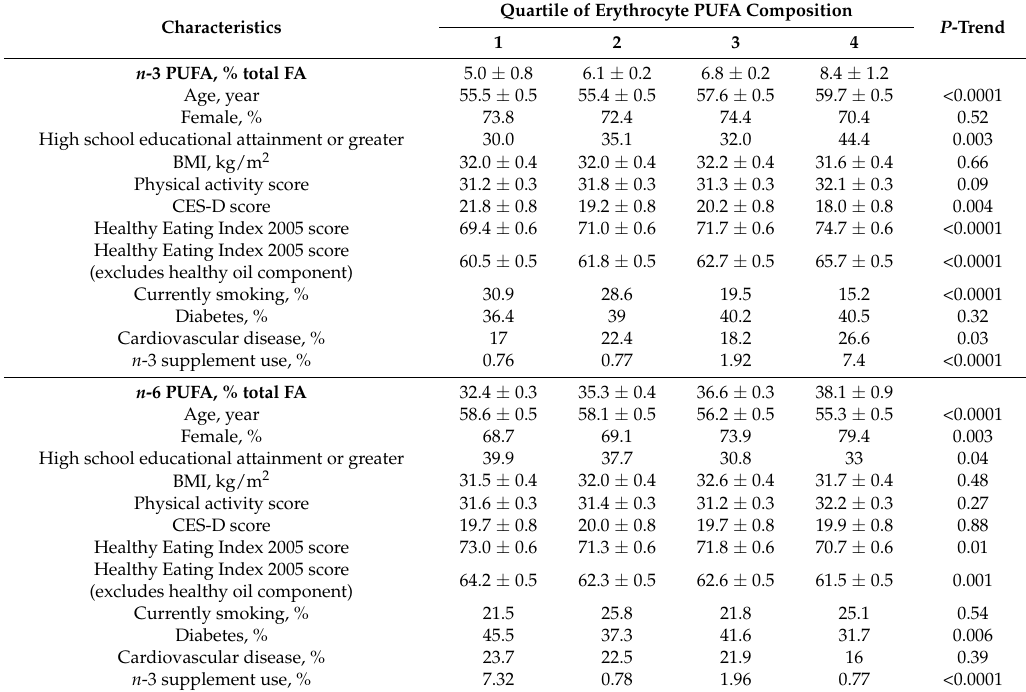
Table 1. Baseline sample characteristics by quartile of erythrocyte PUFA composition ( n = 1032).